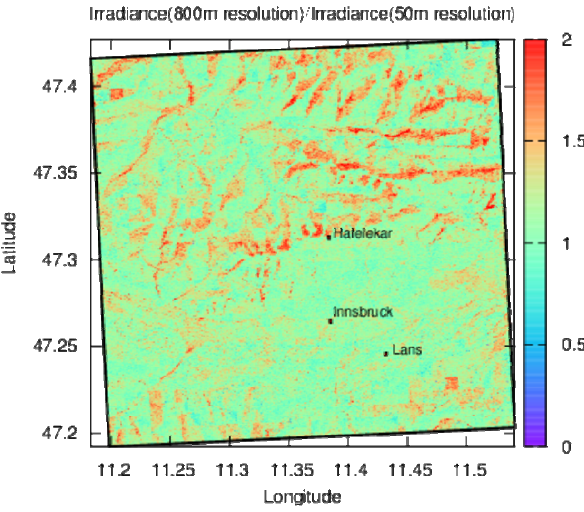
Fig. 7. 3-D radiative transfer simulation of the 305nm irradiance on 24 February 2008 08:20UTC (70 degree solar zenith angle) using a Fig. 9. Ratio of 3-D model irradiance calculation using the 800m DEM with 800m resolution for the Innsbruck area. DEM to 3-D model irradiance calculation using the 50m DEM. Cal- Figure 7: 3-D radiative transfer simulation of the 305 nm irradiance on 24 th February 2008 Figure 9: Ratio of 3-D model irradiance calculation using the 800m DEM to 3-D model culations were performed at 8:20 UTC (70 degree solar zenith angle) using a DEM with 800 m resolution for the irradiance calculation using the 50 m DEM. Calculations were performed at 305 nm. Innsbruck area.